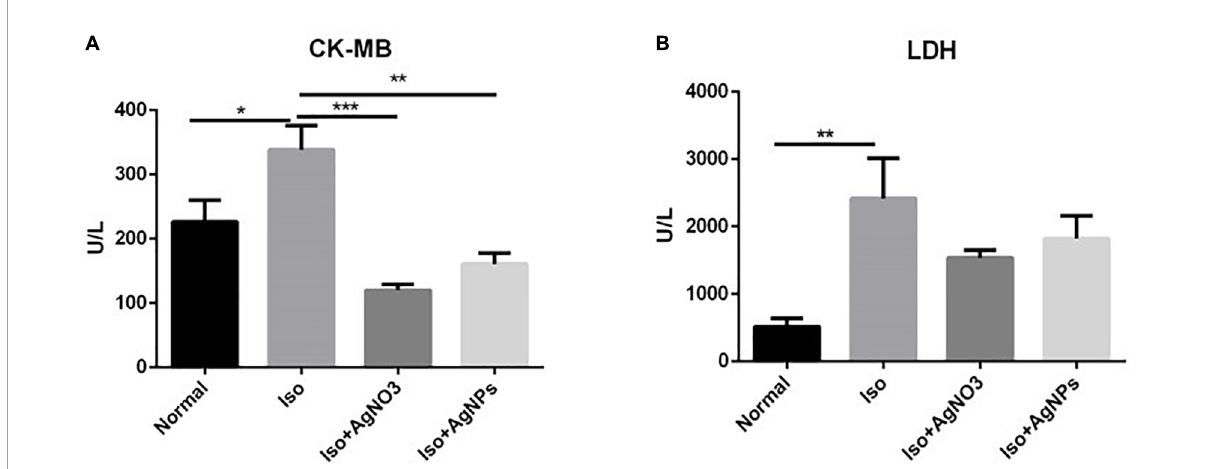
FIGURE4 The effects of AgNO 3 and AgNPs on CK-MB (A) and LDH (B) on Iso-induced MI in rats. Each column represents the mean ± SEM of six rats. Data analysis was performed using one-way ANOVA, followed by Tukey multiple comparison test. *** P < 0.001; ** P < 0.01; * P < 0.05. CK-MB, creatinine phosphokinase isoenzyme; LDH, lactate dehydrogenase; Iso, isoproterenol; AgNO 3 , silver ion; AgNPs, silver nanoparticles.